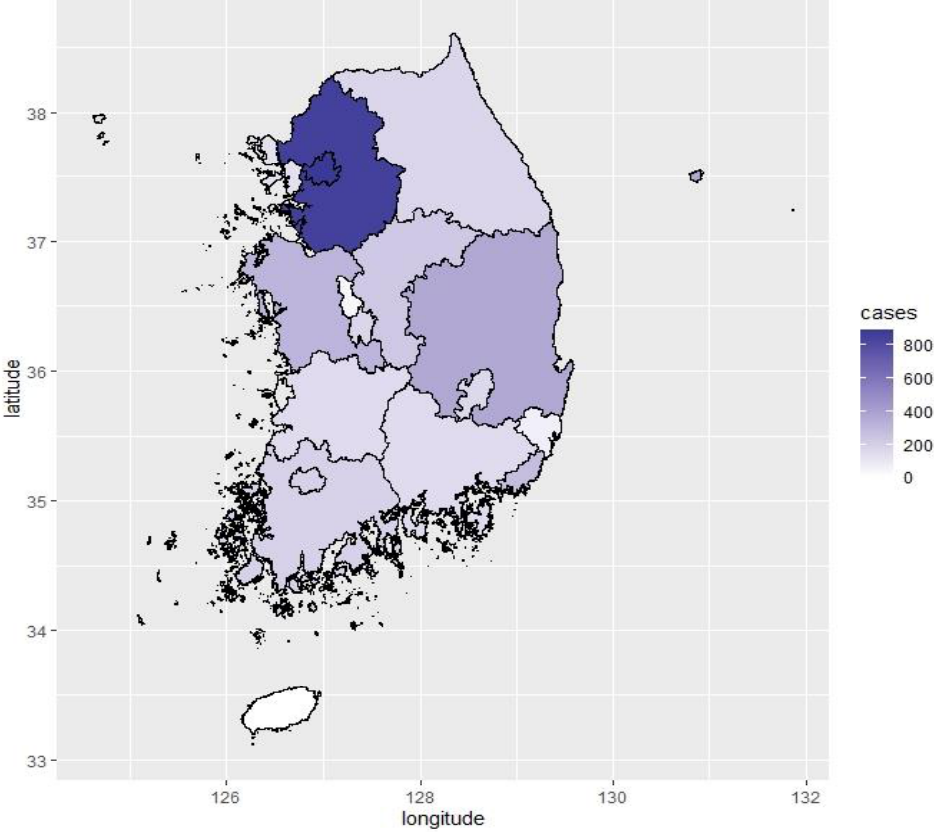
Figure 2. Map of the number of railway accidents.